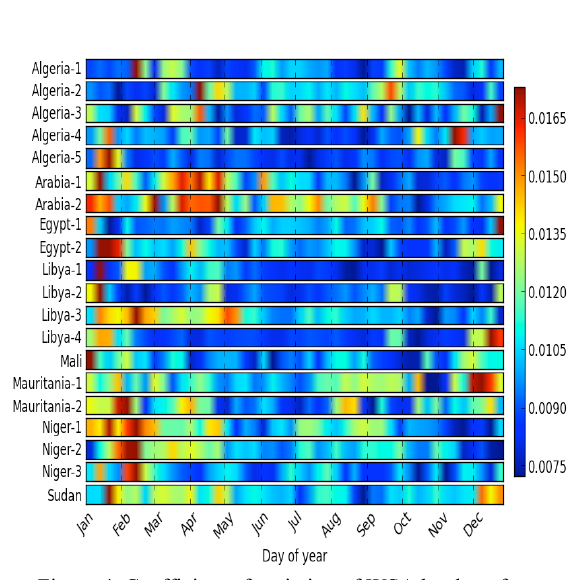
Figure 4. Coefficient of variation of WSA by day of year.